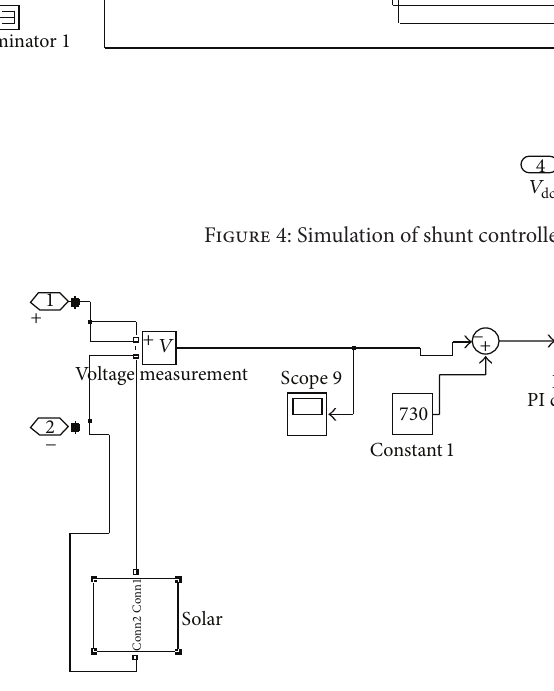
Figure 5: DC link